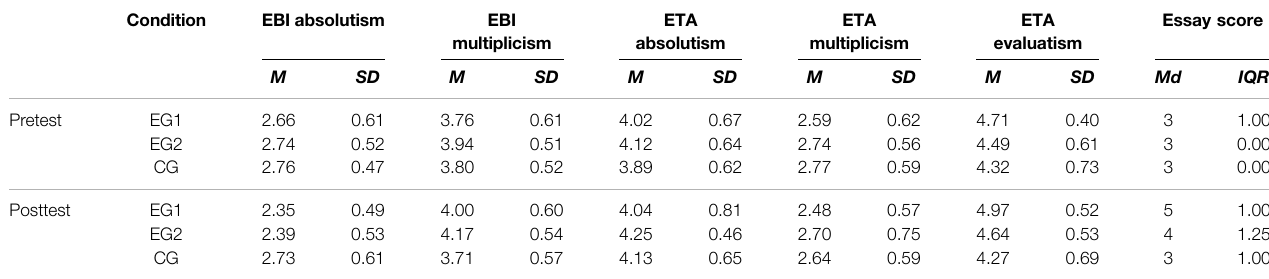
TABLE 3 | Descriptive statistics epistemological belief scales and the essays scores at pre- and posttest for each experimental condition. Condition